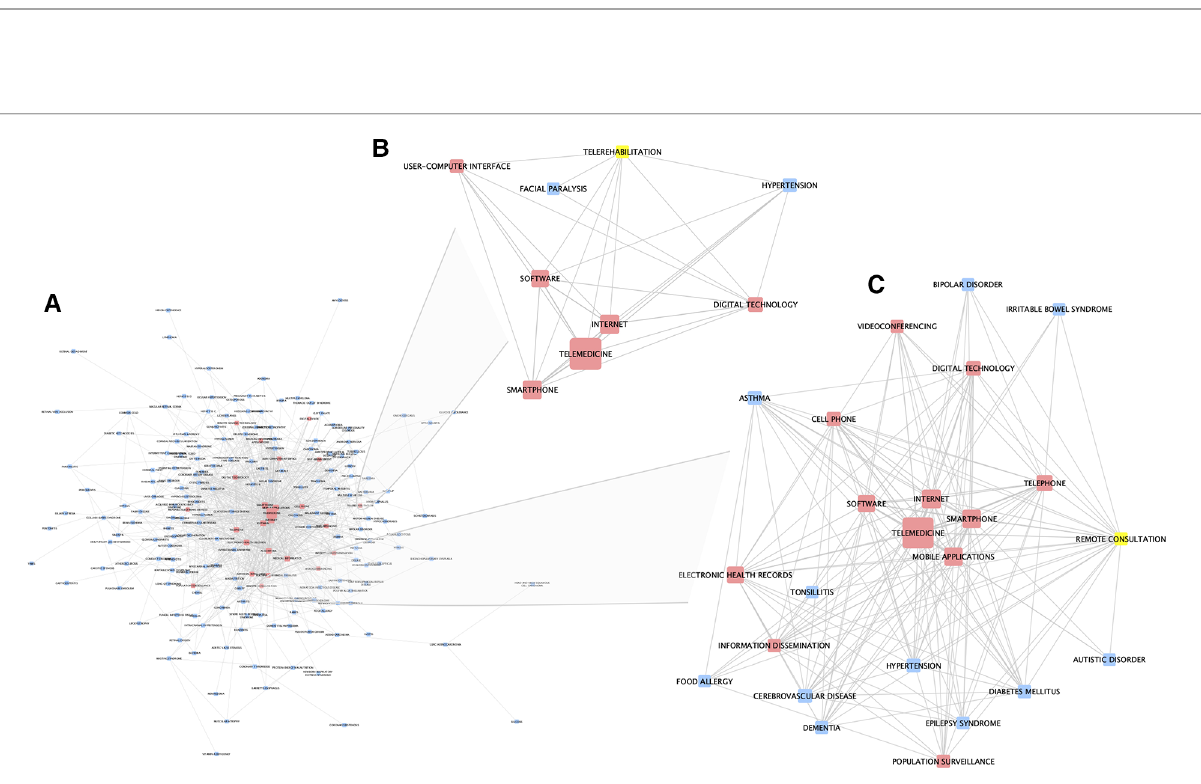
FIGURE 3 Network analysis of associations between disease and digital-health related approaches, as captured in PubMed publications. ( A ) The whole network (also available in supplementary material). ( B ) Sub-network of fi rst-degree neighbors of the node “ telerehabilitation ” . ( C ) Sub-network of fi rst-degree neighbors of the node “ remote consultation ” . Red nodes represent digital health related terms, blue nodes represent diseases, and yellows nodes represent selected nodes used to create the sub-network. The width of edges between nodes corresponds to the number of associations (co-occurrences) between the two entities; the size of the nodes corresponds to the count of that entity within the mined